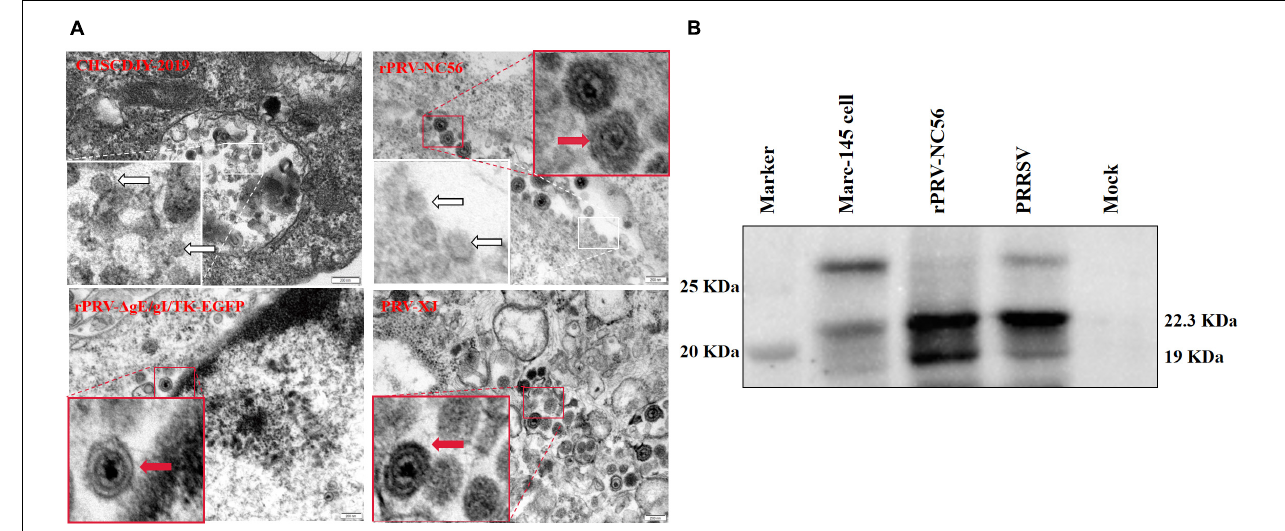
FIGURE 4 | Transmission electron microscopy analysis of PRRSV, PRV XJ, rPRV XJ- (cid:49) gE/gI/TK-EGFP, and rPRV-NC56 in Marc-145 cells. (A) PRRSV CHSCDJY-2019 PRV XJ, rPRV XJ- (cid:49) gE/gI/TK-EGFP, and rPRV-NC56 in Marc-145 cells. The red arrow indicates PRV virus particles, and the white arrow indicates PRRSV virus particles and virus-like particles. (B) PRRSV GP5 and M proteins in ultrafiltration cell culture supernatant of Marc-145 cells infected with rPRV-NC56 were identified by Western blotting. Virus-like particles (VLPs) assembled by GP5 and M proteins will be intercepted by ultrafiltration column (100 kDa).